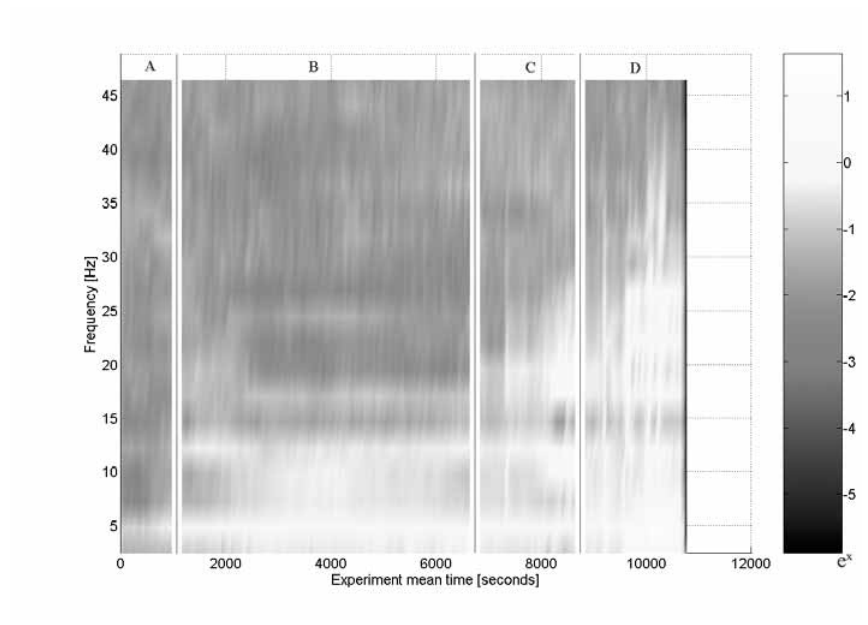
Fig. 18. Comparison of the Global and estimated forces from Class III